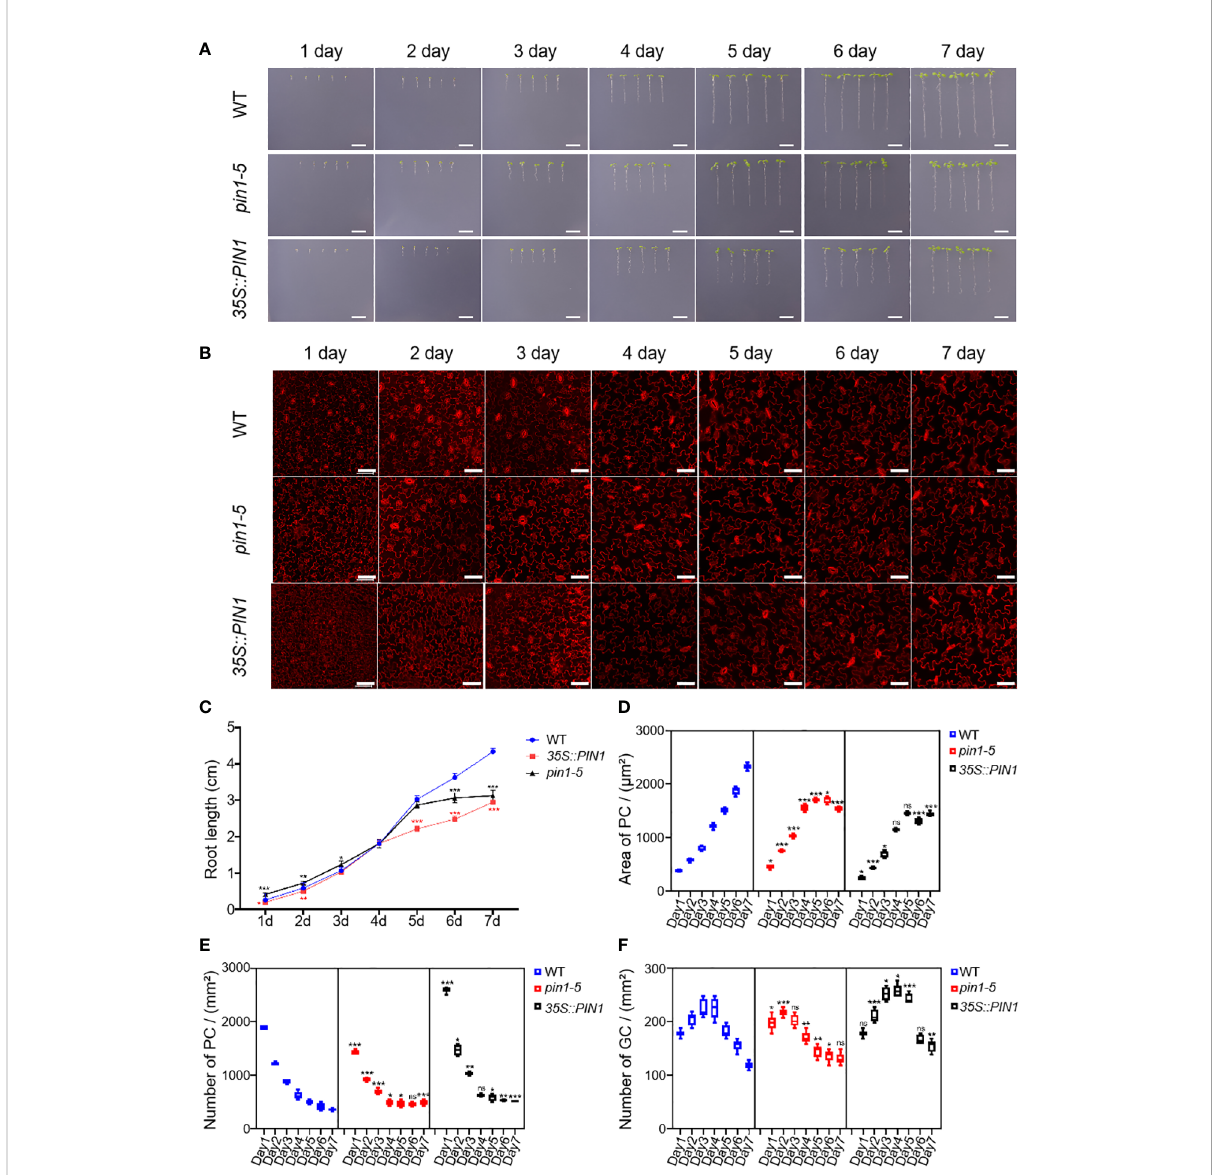
FIGURE 4 Pavement cells (PCs) and guard cells (GCs) development analysis of pin1-5 , 35S::PIN1 , and WT under normal conditions. Analysis of the growth of pin1- 5 , 35S::PIN1 and WT under control conditions. (A) The seeding of pin1-5 , 35S::PIN1 and WT were grown on 1/2MS medium for 7 days. The seedlings born 1-7 were photographed continuously by a camera to record their developmental and growth phenotypes. Untreated seedlings were used as controls. Scale bar: 1 cm. (B) The development of PC and GC was measured under the following conditions: pin1-5 , 35S::PIN1 and WT seedlings were cultured in 1/2 MS medium for 1-7 days, then harvested and stained with propyl chloride (PI) for 30 min to stain the membrane. After PI staining, PC and GC ′ s were detected under a confocal laser microscope. Scale bar: 50 m m. (C) Statistical analysis of the root length of seedlings of pin1-5 , 35S::PIN1 and WT (n = 5). (D) Statistical analysis of the size of PCs in the lower epidermis of cotyledons of seedlings of pin1-5 , 35S::PIN1 and WT (n = 5). (E) Statistical analysis of the intensity of PCs in the lower epidermis of cotyledons of seedlings of pin1-5 , 35S::PIN1 and WT (n = 5). (F) Statistical analysis of the intensity of GCs in the lower epidermis of cotyledons of seedlings of pin1-5 , 35S::PIN1 and WT (n = 5). The data were analyzed by one-way ANOVA following Brown – Forsythe test. ns: p > 0.05; *p < 0.05; **p < 0.01; ***p <